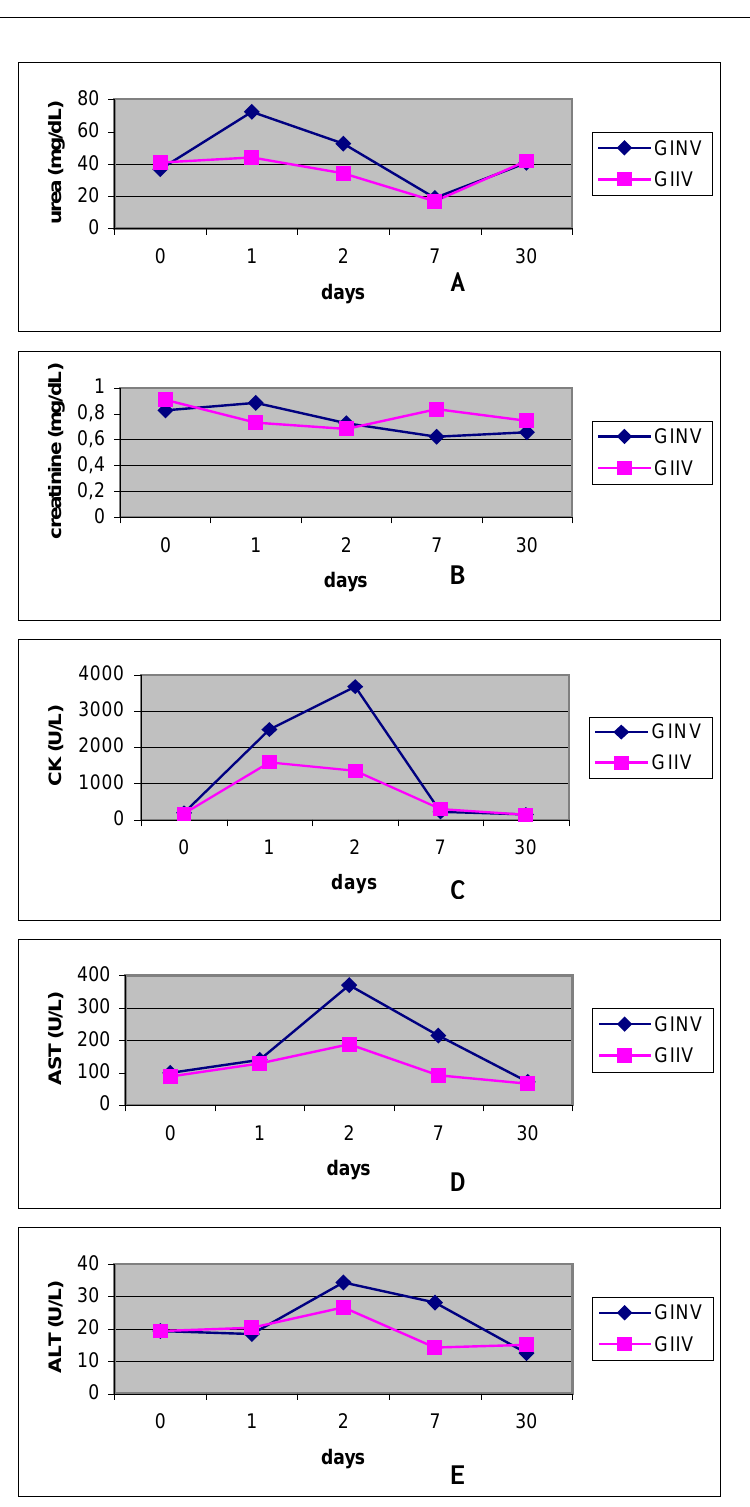
Figure 6. Biochemical data (A: urea, B: creatinine, C: creatine kinase–CK, D: aspartate aminotransferase–AST, E: alanine aminotrasferase–ALT) in animals of the group inoculated with natural venom (GINV) and the group inoculated with irradiated venom (GIIV) before and after venom